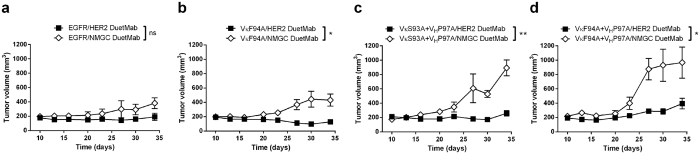
Antitumor activity of monospecific and bispecific EGFR affinity-modulated variants in nude mice bearing single-flank NCI-H358 xenografts.(a) Antitumor activity of parental GA201 formatted as either bispecific anti-EGFR/HER2 DuetMab or monospecific anti-EGFR/NMGC DuetMab. (b) Antitumor activity of variant VκF94A formatted as either bispecific anti-EGFR/HER2 DuetMab or monospecific anti-EGFR/NMGC DuetMab. (c) Antitumor activity of variant VκS93A + VHP97A formatted as either bispecific anti-EGFR/HER2 DuetMab or monospecific anti-EGFR/NMGC DuetMab. (d) Antitumor activity of variant VκF94A + VHP97A formatted as either bispecific anti-EGFR/HER2 DuetMab or monospecific anti-EGFR/NMGC DuetMab. Single-flank tumor bearing mice were treated twice weekly with monospecific and bispecific formats of the EGFR affinity-modulated variants for a total of 8 treatments and tumor growth inhibition was measured twice weekly. Tumor size represents the mean values of 5 mice per treatment group and the ± standard error of the mean (SEM) is represented by error bars. Statistical comparisons were conducted by calculating the area under the curve (AUC) comparing each monospecific DuetMab with its corresponding bispecific DuetMab. Statistical significance was determined by unpaired t-test (P < 0.05 *P < 0.01 **P < 0.001 ***P < 0.0001 ****ns: not significant).